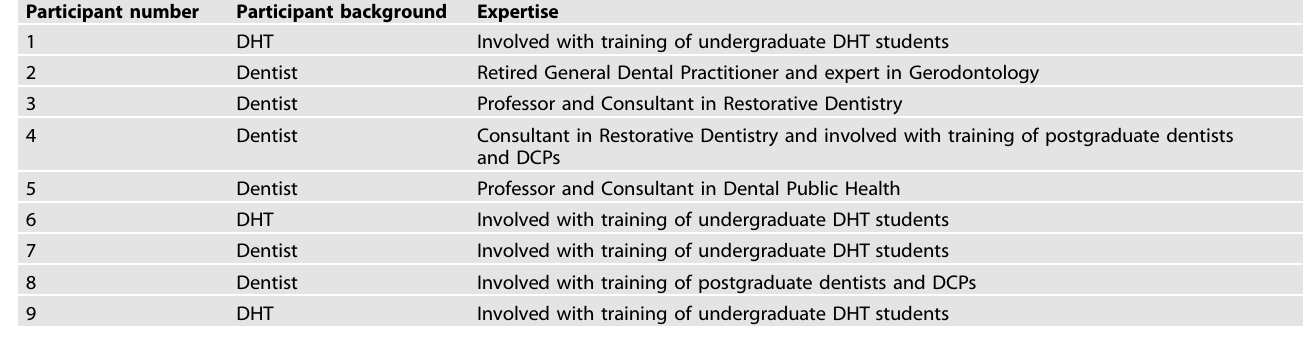
Table 1. Participant background and expertise.